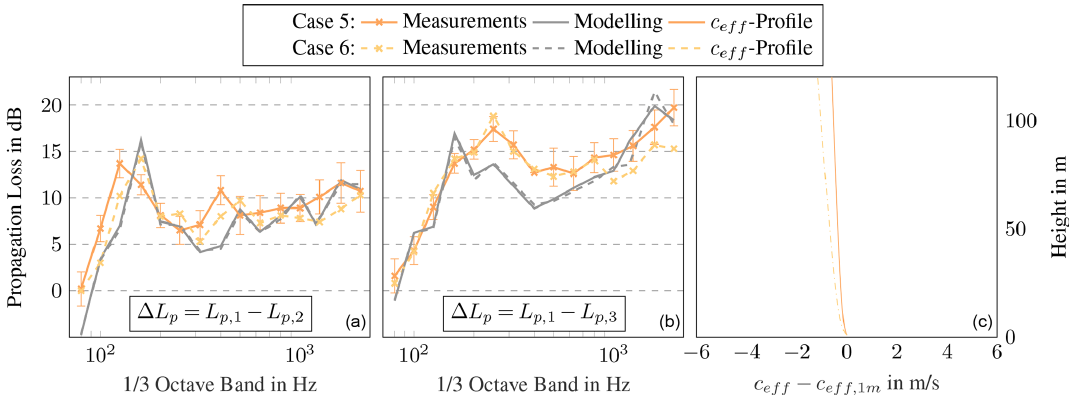
Figure A1. Comparison of measured and modelled propagation losses per one-third octave band for cases 5 and 6. (a) Propagation losses between Mic 1 (178m) and Mic 2 (535m), including standard deviation for measurement in case 5. (b) Propagation losses between Mic 1 (178m) and Mic 3 (845m), including standard deviation for measurement in case 5. (c) Normalised profiles of effective sound